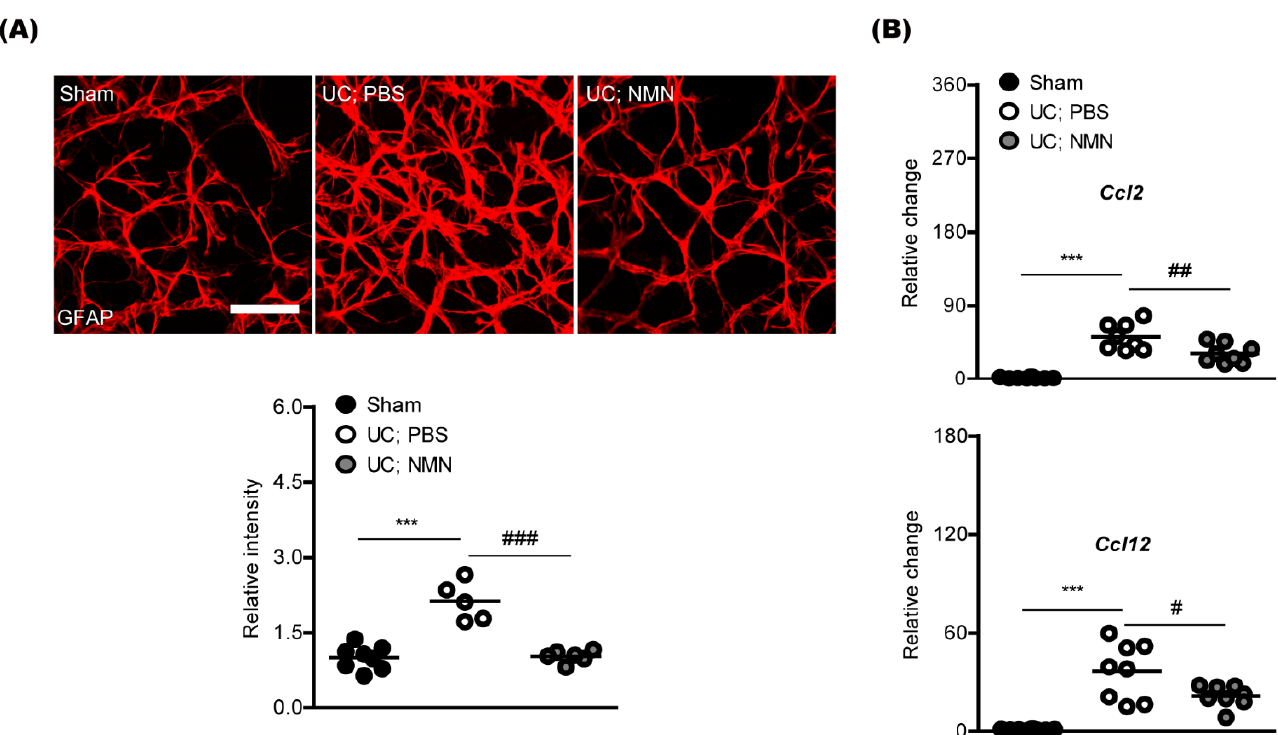
Figure 2. Modulation of pathological retinal gliosis and inflammation by consecutive NMN treatment. ( A ) Representative images and quantitative analyses (n = 5–8 per group) demonstrated that NMN treatment suppressed increases in GFAP immunoreactivities induced by UCCAO. Scale bar, 50 µ m. *** p < 0.001; ### p < 0.001. One-way ANOVA followed by a Bonferroni post hoc test. A graph is shown as mean with actual values (mean and standard deviation, sham: 1.00, 0.23; UC; PBS: 2.12, 0.39; UC; NMN: 1.02, 0.12). ( B ) Quantitative analyses (n = 8 per group) demonstrated that NMN administration reduced upregulation in Ccl2 and Ccl12 mRNA expressions in the ischemic retina. *** p < 0.001; # p < 0.05, ## p < 0.01. One-way ANOVA followed by a Bonferroni post hoc test. Graphs are shown as mean with actual values (mean and standard deviation, sham: 1.00, 1.02; UC; PBS: 51.95, 16.42; UC; NMN: 31.46, 11.72; sham: 1.00, 0.38; UC; PBS: 36.54, 17.33; UC; NMN: 21.50, 6.54). UC, UCCAO.